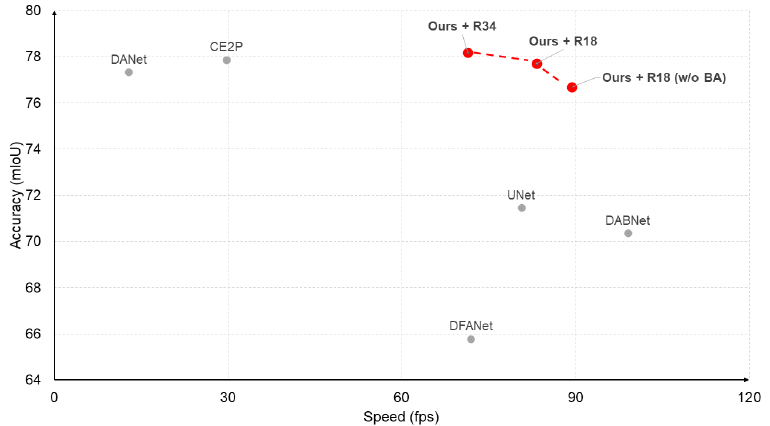
Figure 5. Runtime and mIoU (mean intersection of union) on CelebAMask-HQ. “R” denotes ResNet backbone (i.e., R18 is equivalent to ResNet18). Our method achieved remarkable results in both accuracy and